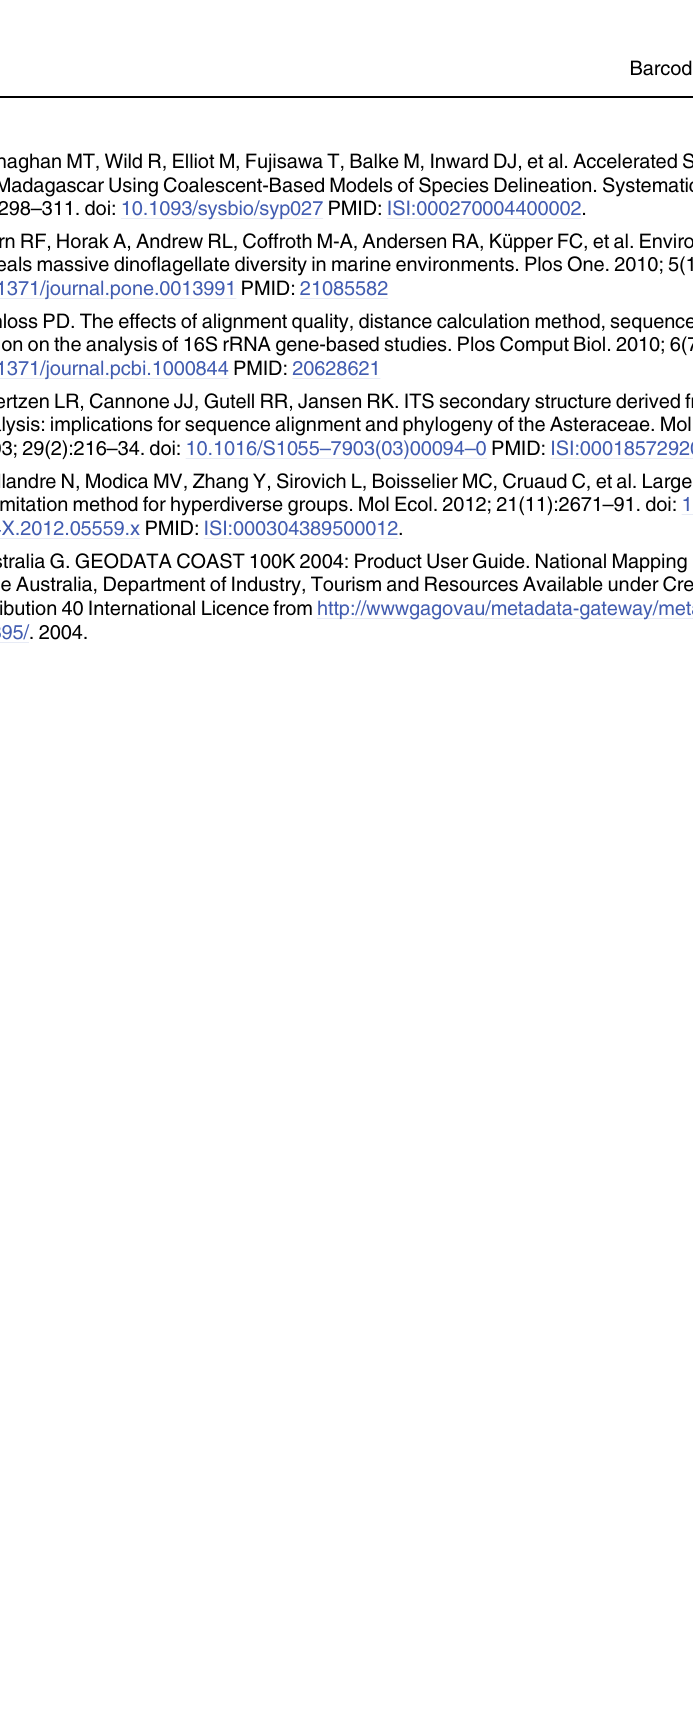
PLOS ONE | DOI:10.1371/journal.pone.0136130 August 26,